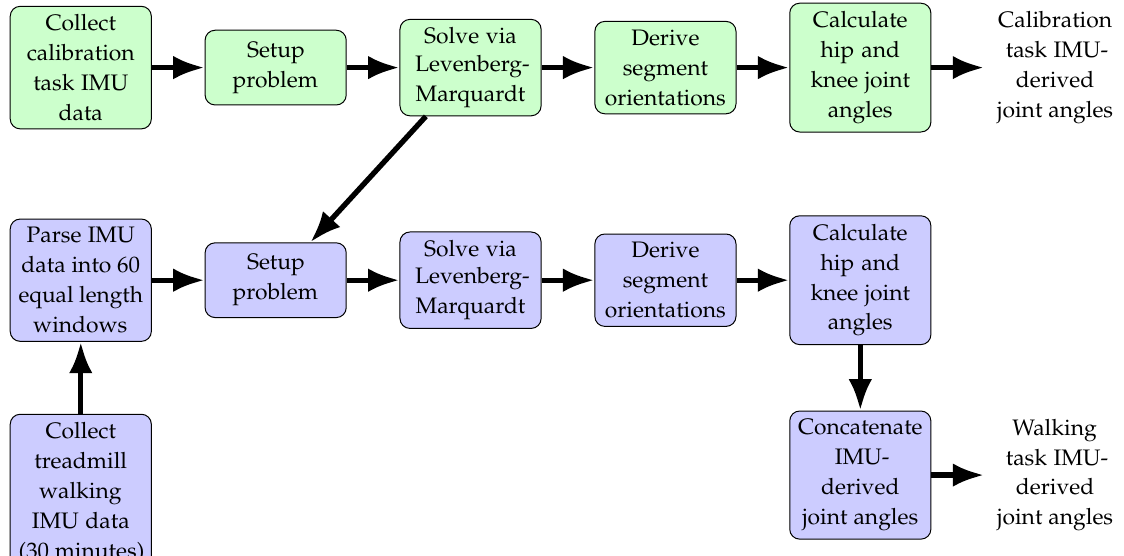
Figure 2. Conceptual process methodology to compute IMU-derived joint angles for both the calibration task (green) and the treadmill walking task (purple). Calibration task computed solutions the four hip-connected joint center vectors are used as priors in the walking task problem. Levenberg– Marquardt is used as an iterative solver to the proposed optimization problem. Knee joint angle results from the calibration task are reported in McGrath and Stirling [47]. Knee angles are derived according to Grood and Suntay [54] and hip angles are derived according to Wu et al.